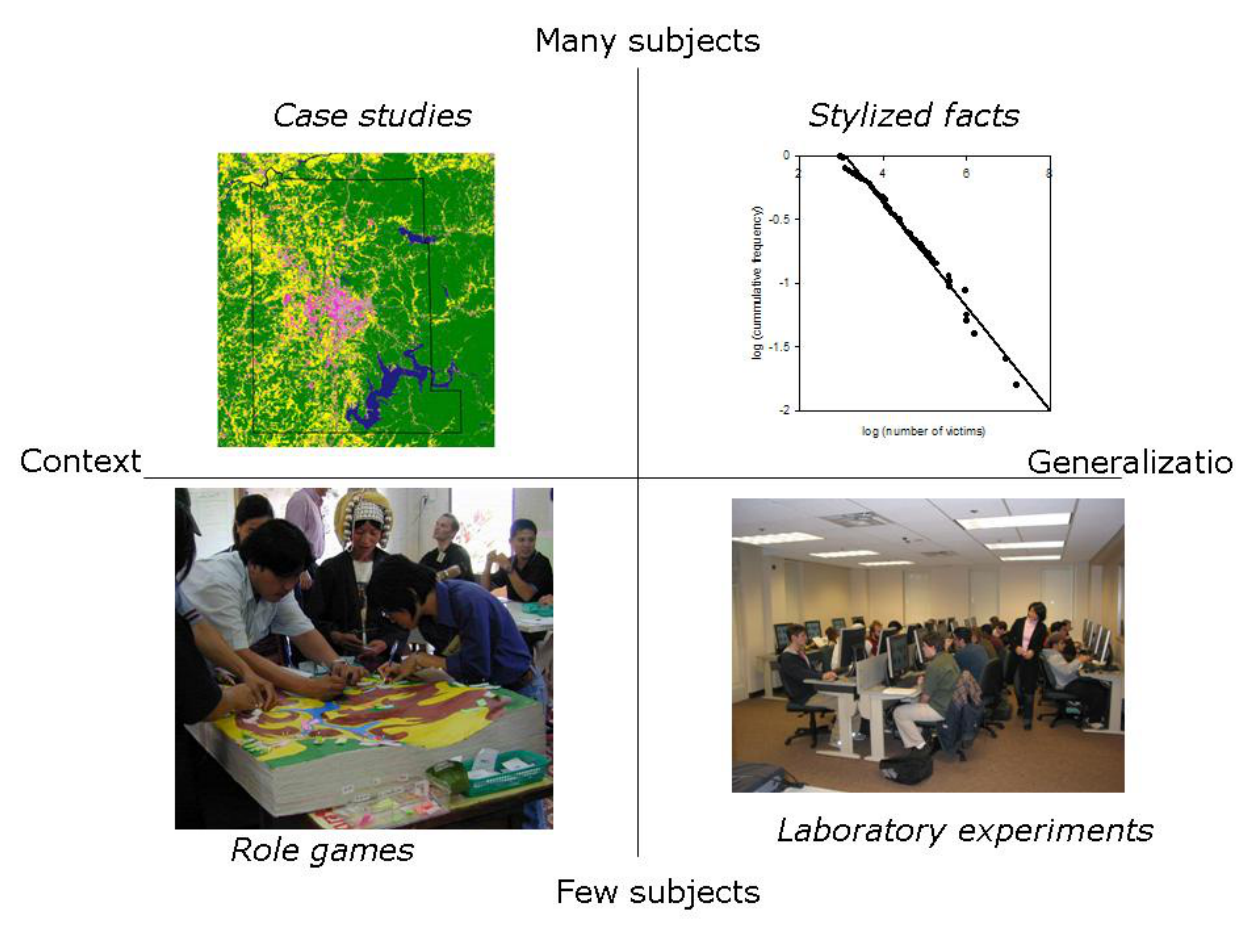
Fig. 2. . The different types of approaches to combine empirical information and agent-based modeling (sources: top-left figure is an adapted version of a remote-sensing image of Monroe County, Indiana, USA created by Cynthia Croissant, Laura Carlson, Glen Green, Tom Evans, Shanon Donnelly, and Charles Winkle; top-right figure is based on Fig. 1 of Cederman (2002); bottom-left photo is provided by Francois Bousquet; and bottom-right photo is provided by James Russell of the Interdisciplinary Experimental Laboratory at Indiana